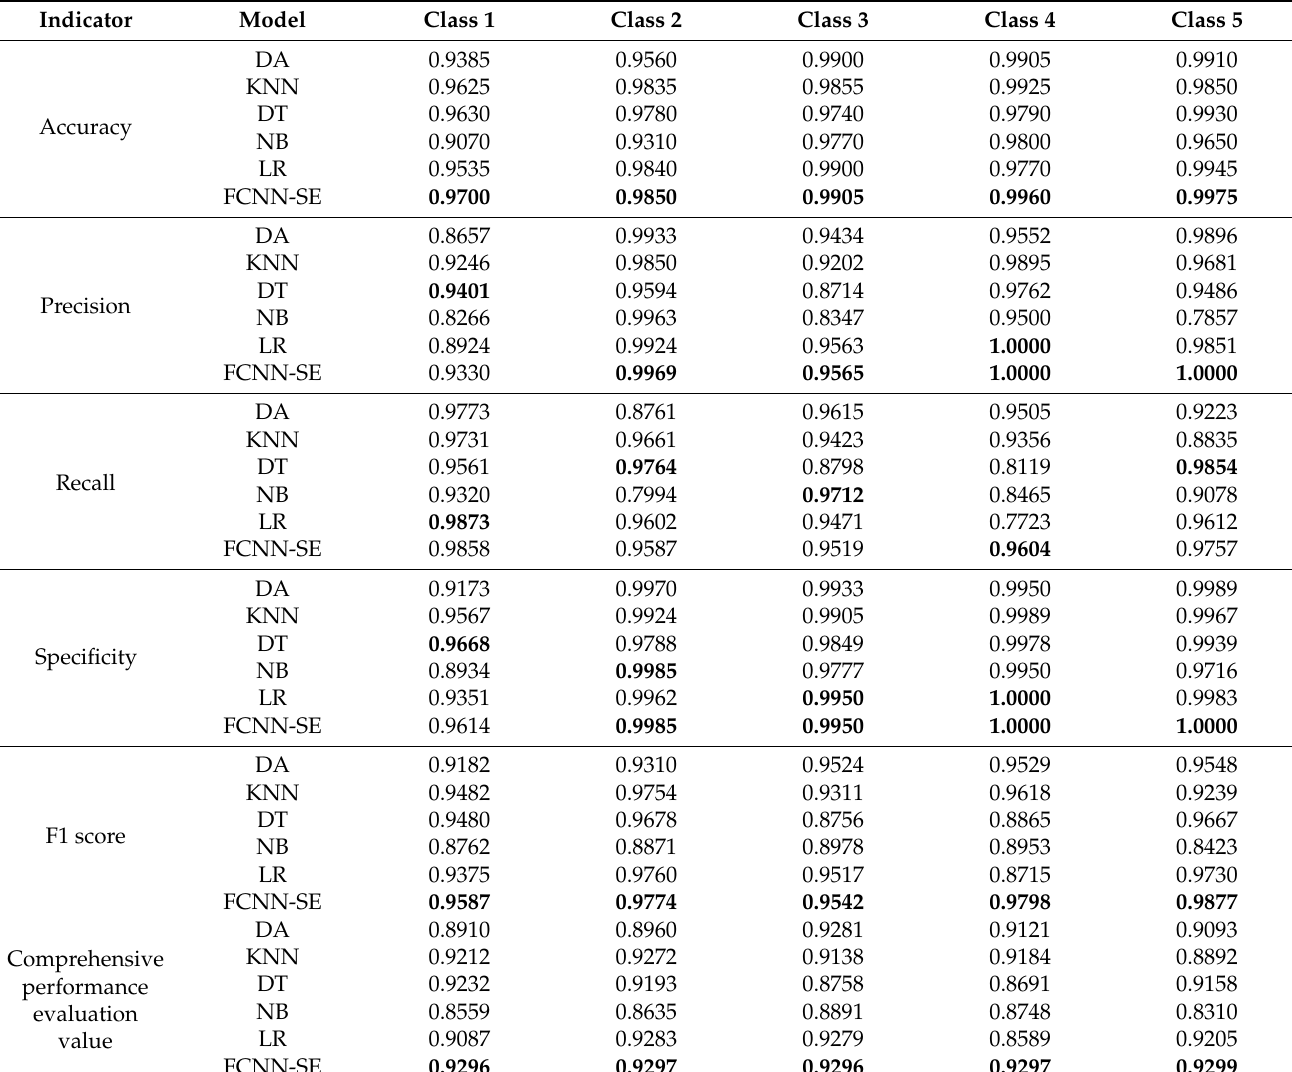
Table A2. Performance comparison between